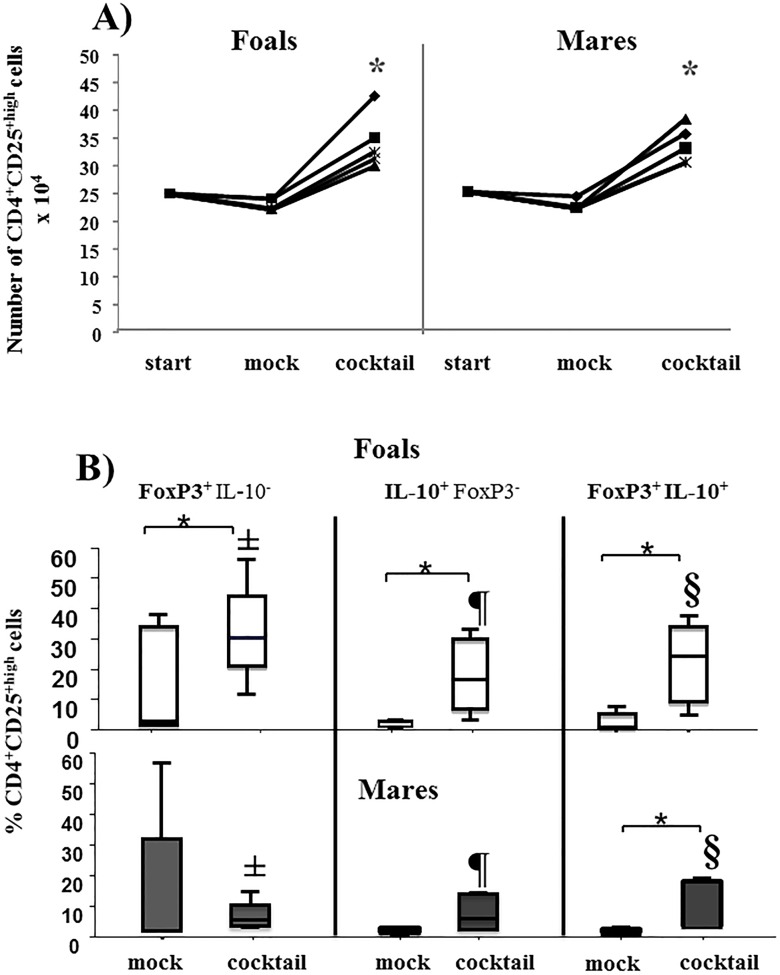
Expansion of circulating CD4+CD25high cells from foals and mares.2.5x105 CD4+CD25high lymphocytes sorted from freshly isolated PBMC of foals (F, n = 5, age 1–2 months) and mares (M, n = 5, age 5–17 years) were left either un-stimulated (mock) or stimulated with cocktail. A) The cells were counted before (start) and after culture (mock, cocktail) using a haemocytometer and Trypan blue to exclude dead cells. Results are shown as number of cells, dots represent individual horses. * Indicates significant differences to mock and start using paired t-test. B) After 4 days, the cells were harvested and stained for FoxP3 and IL-10. The percentage of single positive FoxP3
+IL-10−, single positive IL-10
+FoxP3− and double positive IL-10
+
FoxP3
+ was measured by flow cytometry. Results are shown as percentages and presented as box plots. An asterisk with line indicates significant difference of cocktail to mock within the respective cell subpopulation and same horse group using non-parametric Wilcoxon signed-rank paired t-test. ±, ¶, § indicate statistical significance difference between foals and mares within the respective cell population using non-parametric Mann-Witney U test. *p ≤0.05 was considered significant.